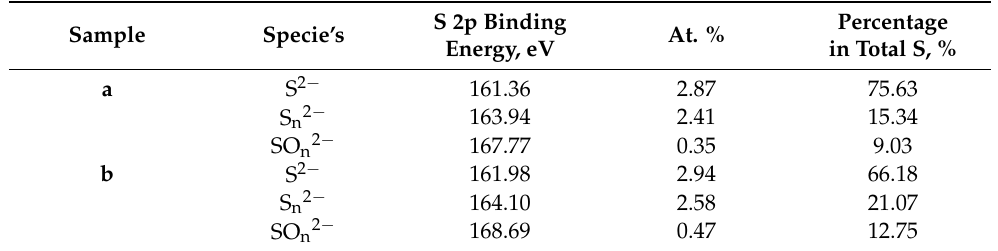
Table 2. Binding energy and percentage in total S of different S species on (a) malachite + 0.06 M